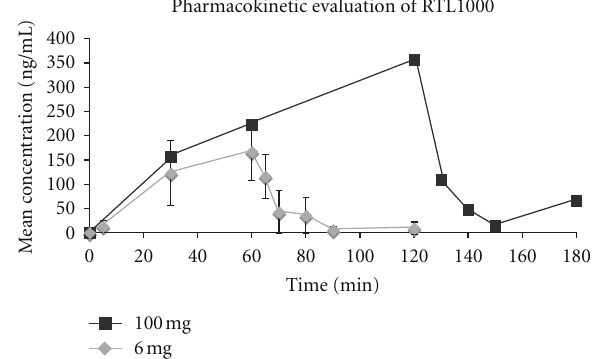
Figure 5: Pharmacokinetic profile of RTL1000. The mean concen- tration of RTL1000 was assessed in plasma collected from study subjects at the indicated times prior to and after IV infusion of 6mg (Cohort 2) or 100mg (Cohort 6) RTL1000. Based on these and other assessments (not shown), the half-life of RTL1000 was determined to be 4 . 86 ± 2 . 04 min, with increasing exposure (C max and AUC last ) observed with increasing dose. Clearance values ranging from 3250 to 44800 mL/min were much greater than hepatic blood flow and indicate that RTL1000 was rapidly eliminated via a nonhepatic mechanism. The high nonphysiological volumes of distribution ranging from 30.8 to 202 liters indicate that RTL1000 is tightly bound to sites not present in